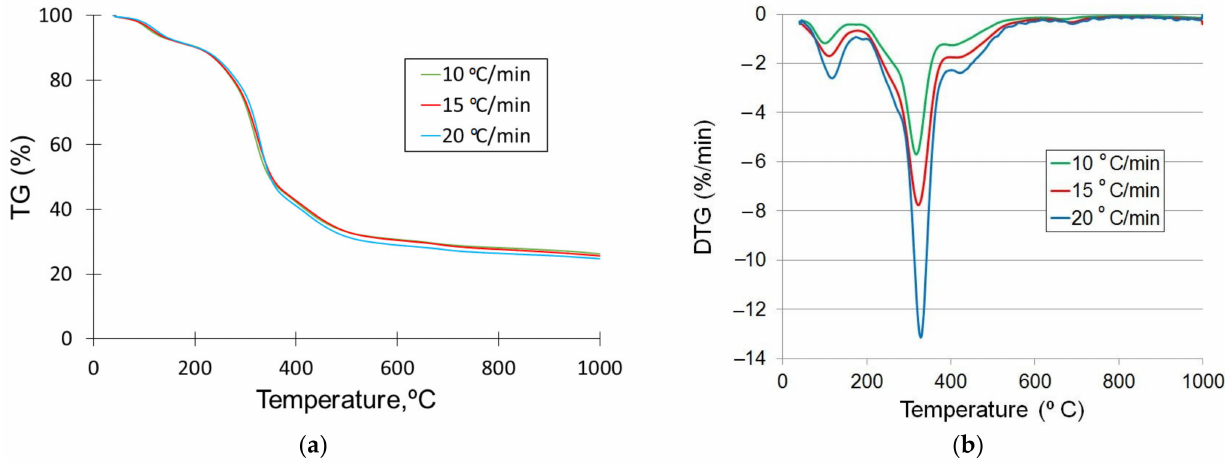
Figure 4. ( a ) TG − curves; ( b ) DTG − curves.